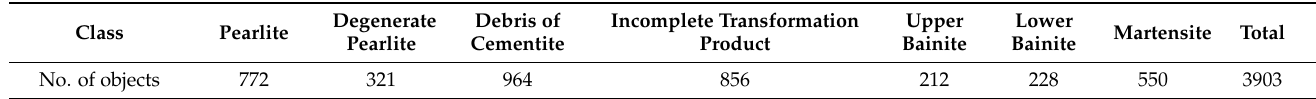
Table 1. Summary of class distribution in final annotated dataset.